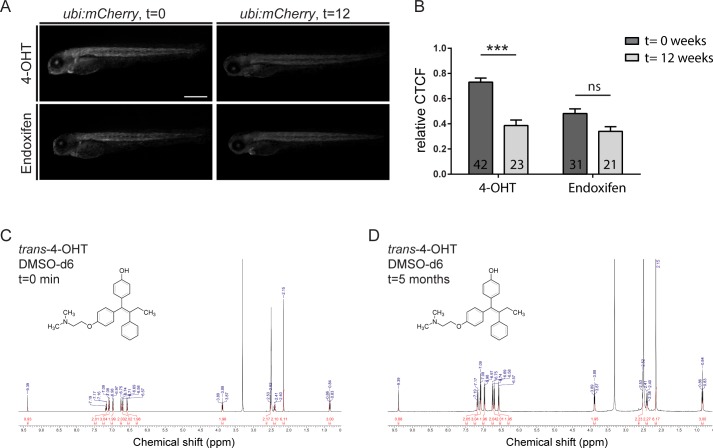
In contrast to Endoxifen, trans-4-OHT loses its potency over time independently from isomerization.(A) Switching efficiency was quantified comparing fresh and 12 weeks old trans-4-OHT and Endoxifen (scale bar 500 μm). (B) mCherry intensity in embryos treated with 12 weeks old trans-4-OHT is approximately half compared to intensities measured in embryos induced with fresh trans-4-OHT (two-tailed, unpaired t-test, p<0.0001). The potency of Endoxifen does not change significantly throughout the same time period (two-tailed, unpaired t-test, p = 4598). (C) The 1H NMR spectrum of trans-4-OHT freshly dissolved in DMSO-d6 reveals the presence of ≥98% of the trans isomer. (D) After 5 months storage in DMSO-d6, no appreciable change in isomer composition can be detected by 1H NMR.